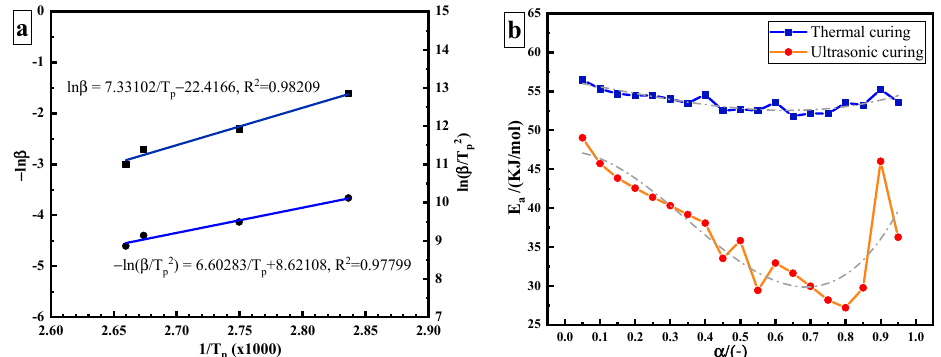
Figure 4. Estimation of the apparent activation energy: ( a ) constant 𝐸 (cid:3028) : Kissinger method and Ozawa method; ( b ) variable 𝐸 (cid:3028) : FRL method.